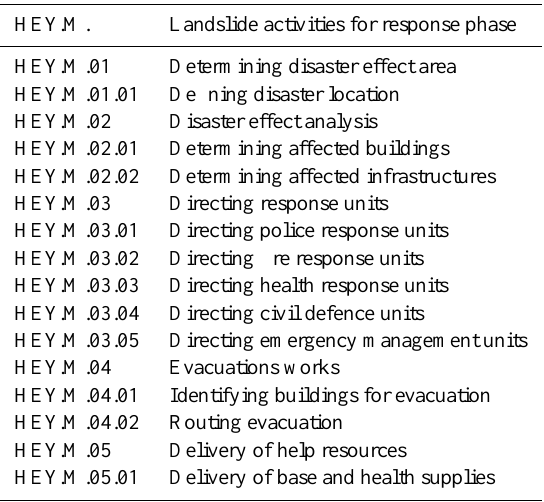
Table 3. Landslide activities for the response phase. HEY.M.